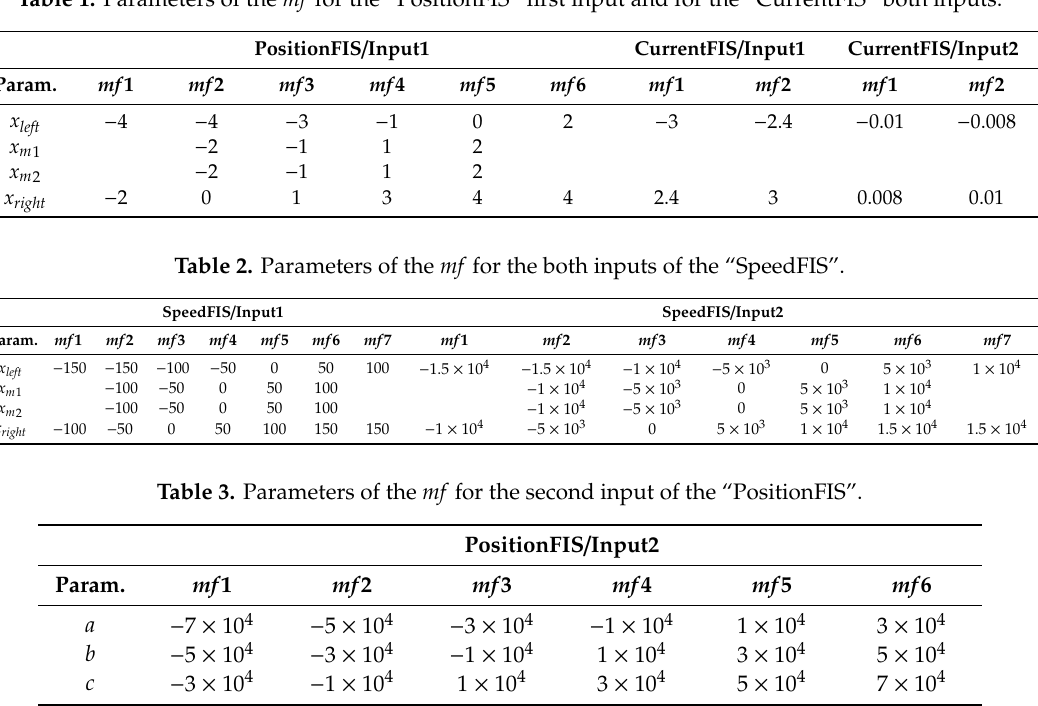
Table 1. Parameters of the mf for the “PositionFIS” first input and for the “CurrentFIS” both inputs.